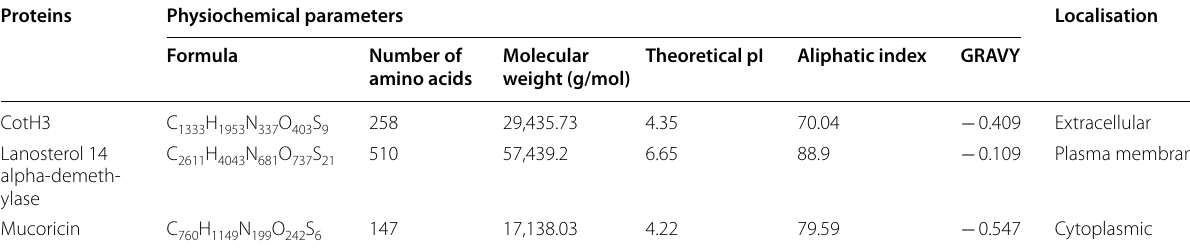
Table 3 Physicochemical property and subcellular location analysis of target proteins Proteins